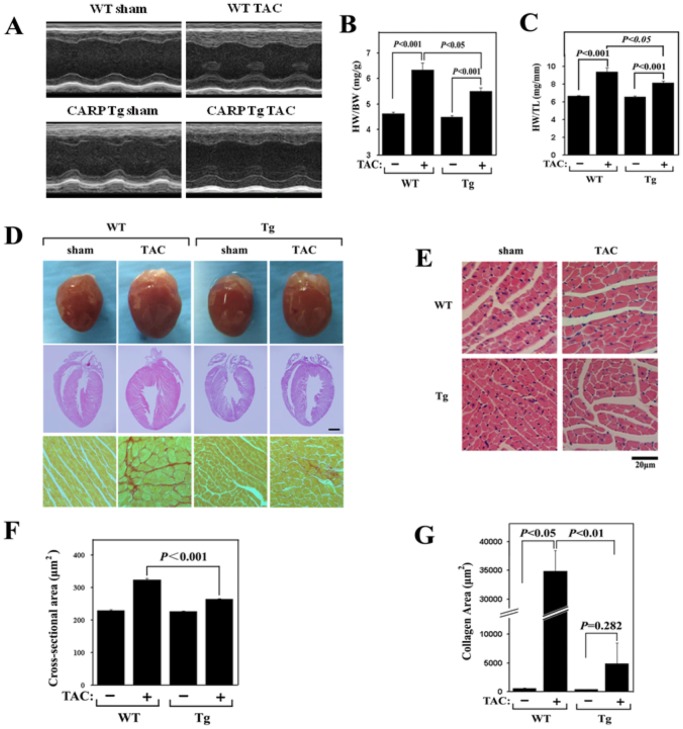
Pressure overload-induced cardiac hypertrophy is attenuated in CARP Tg mice.WT and CARP Tg mice were subjected to TAC or a sham operation. Cardiac hypertrophy and function were assessed by echocardiography. After 4 weeks, the mice were sacrificed for assessment of cardiac hypertrophy. (A) Representative examples of M-mode echocardiograms of hearts from WT and CARP Tg mice subjected to TAC or a sham operation. (B) The ratio of heart weight to body weight (HW/BW). (C) The ratio of heart weight to tibia length (HW/TL). (D) Staining of heart sections from WT and CARP Tg mice subjected to TAC or a sham operation. Upper panel: Gross heart morphology; middle panel: H&E-stained longitudinal sections; lower panel: PSR-stained sections. (E) H&E staining of sections from the left ventricular myocardium of WT and CARP Tg mice subjected to TAC or a sham operation. Scale bar  = 20 µm. (F) Quantification of cross-sectional areas of the cardiomyocytes shown in (E). (G) Quantification of collagen areas in the myocytes shown in (D).